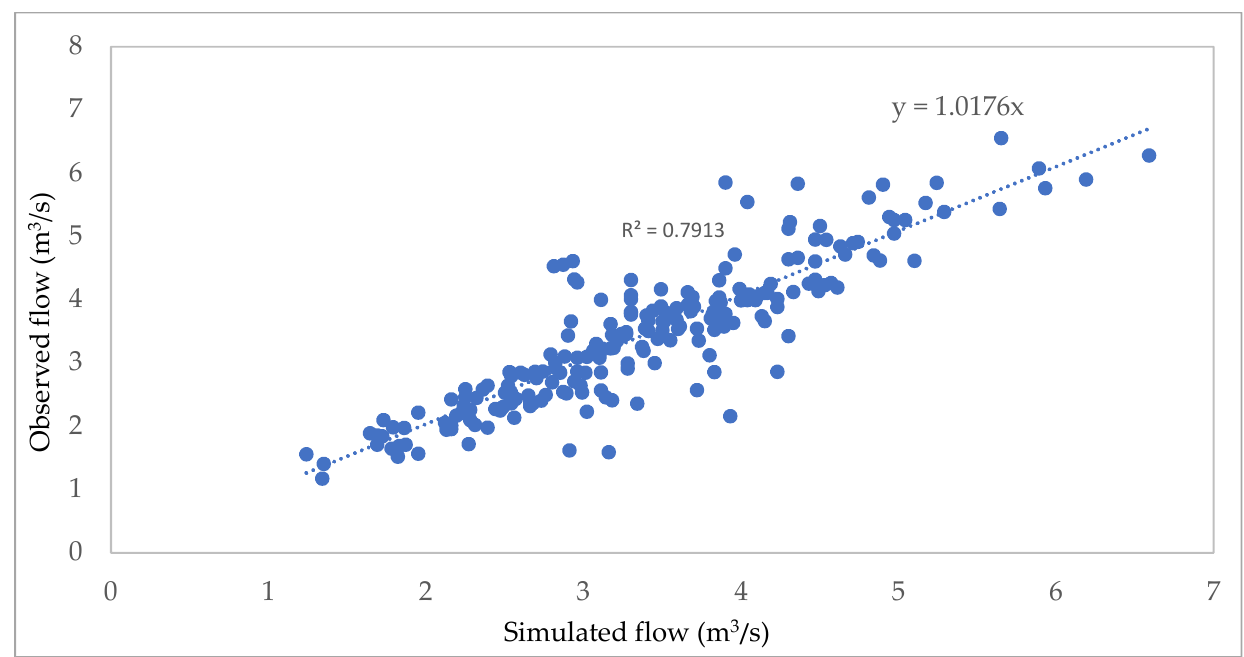
Figure 4. Best fit curve for flow calibration and validation.